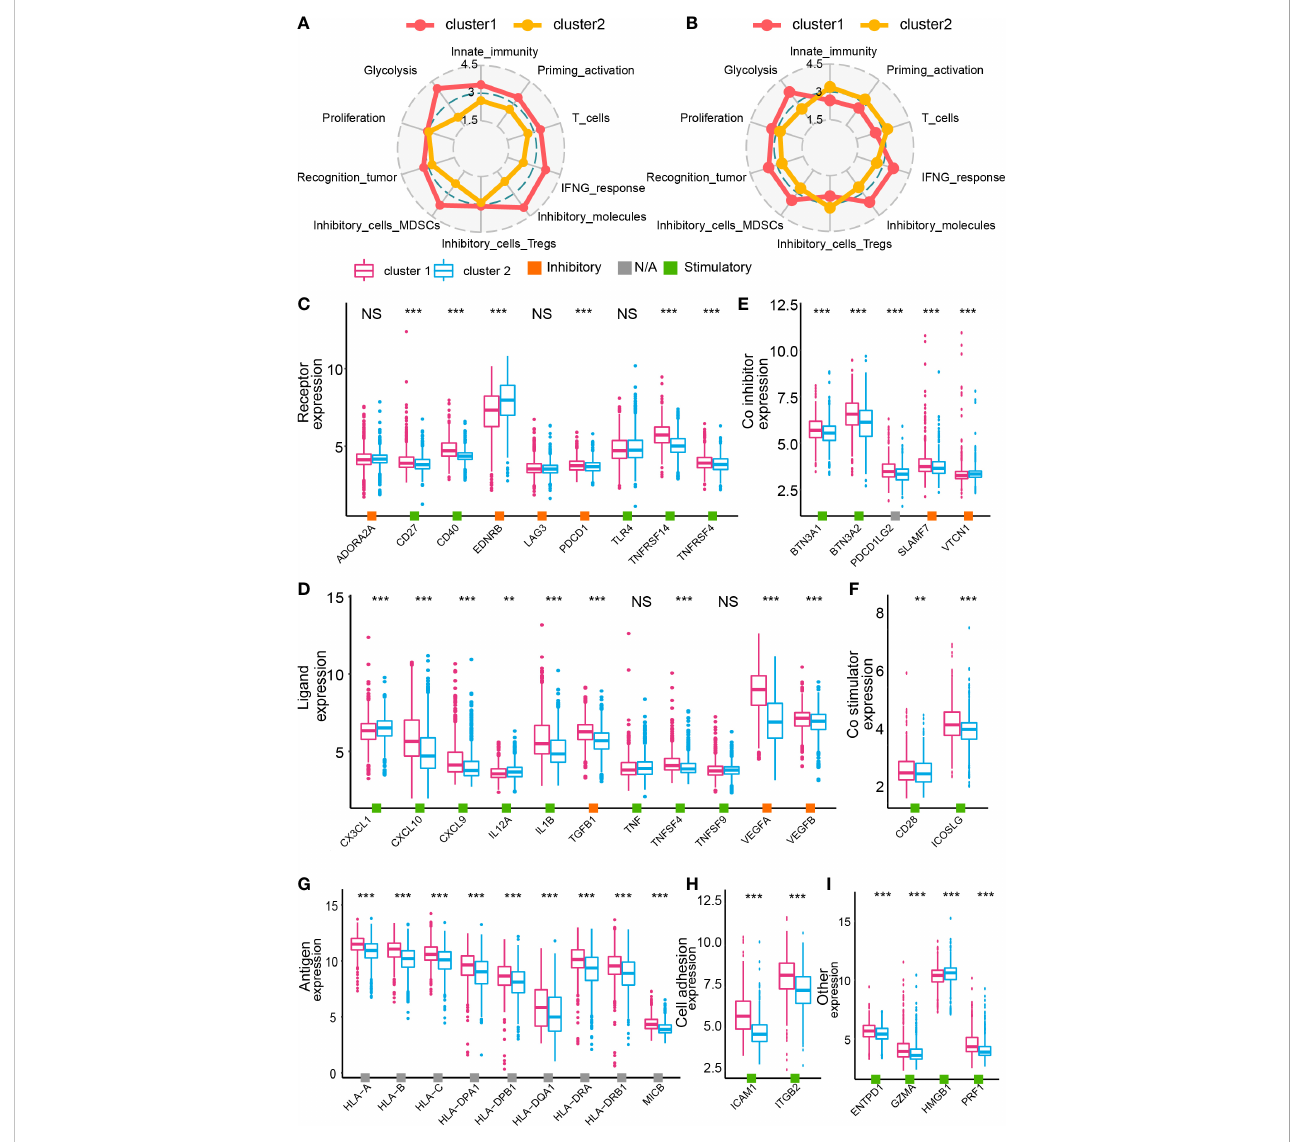
FIGURE 5 The immune landscape of cluster 1 and cluster 2 samples from the GBM meta cohort. Immunogram based on the GBM meta cohort (A) and data from single-cell RNA-seq analysis (B) . The expression of immune inhibitors/contributors, including receptor (C) , ligand (D) , co-inhibitor (E) co-stimulator (F) , antigen (G) , cell adhesion (H) , and other (I) . NS, no signi fi cance, **P < 0.01, ***P <